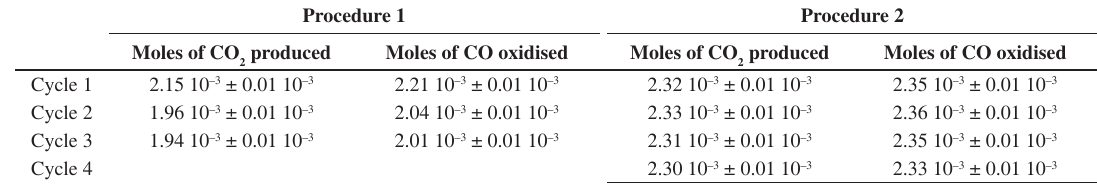
Table 1. Amount of CO produced and CO oxidised during reduction cycles (procedure 1 and 2). 2